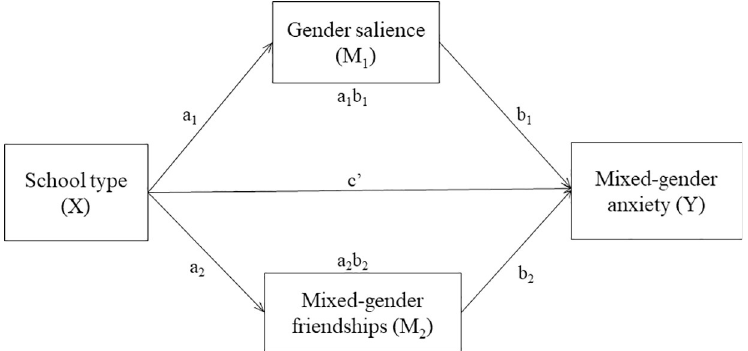
Fig 1. Generic mediation model. In the mediation model, a 1 b 1 denotes the indirect effect (i.e., mediation) of gender salience, a 2 b 2 denotes the indirect effect of mixed-gender friendships, and c’ denotes the direct effect of school type on mixed-gender anxiety.